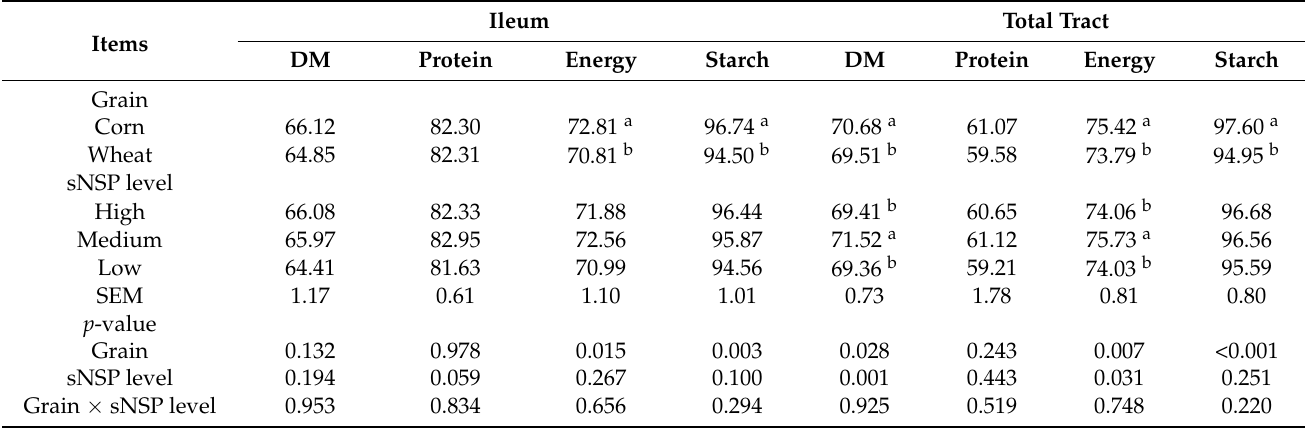
Table 8. Effect of dietary soluble non-starch polysaccharide (sNSP) level and grain source on apparent ileal and total tract digestibility of dry matter (DM) and starch (%) and metabolisability of gross energy (%) and crude protein (%) in broilers at d